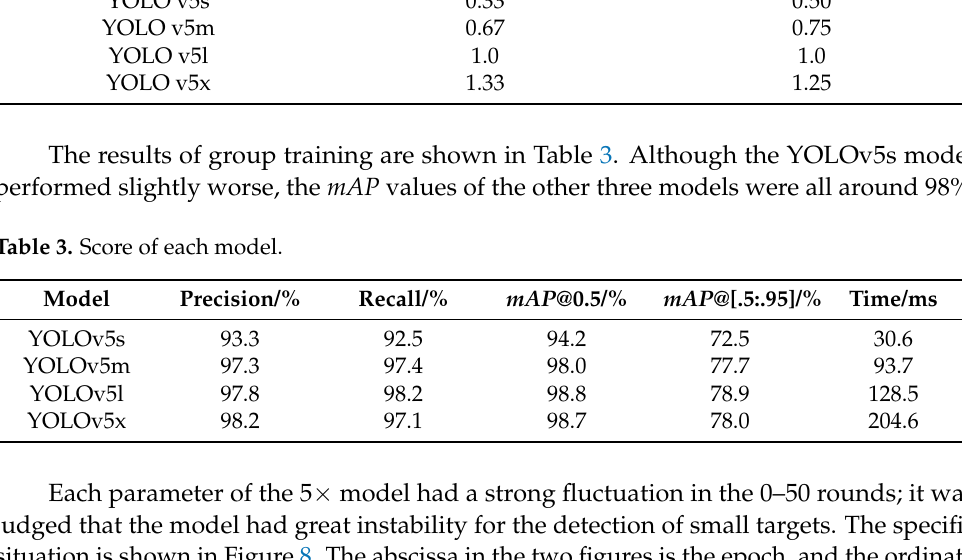
Table 2. Model structure parameter settings.